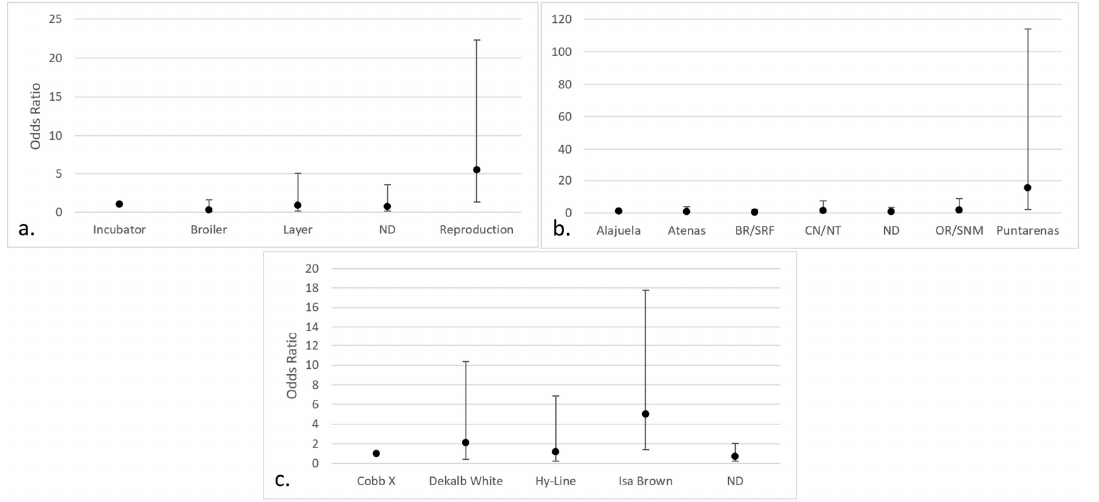
Figure 7. Categories with the highest risk of positive isolates for Aspergillus section Nigri (95% CI) in chicken lungs ( Gallus gallus ) from 2008 to 2021 in the Mycology Laboratory, School of Veterinary Medicine, Universidad Nacional, Costa Rica. ( a ) Productive purpose of the bird; ( b ) county of origin; ( c ) bird breed. ND = non-determinate production purpose; BR/SRF = Barva and San Rafael; CN/NT = counties from the center and north of Alajuela; ND = non-determinate origin and Dota, Santa Ana, Sarapiquí, Turrialba, Turrubares, Upala, Río Cuarto, San Carlos, and Pavas; OR/SNM = Orotina and San Mateo; Cobb X = pure Cobb mixed with Hubb and Ross; Dekalb White = pure Dekalb White mixed with Isa Brown; ND = non-determinate breed and Ross, Redbro, Sasso, Hubbard, and Lohman.